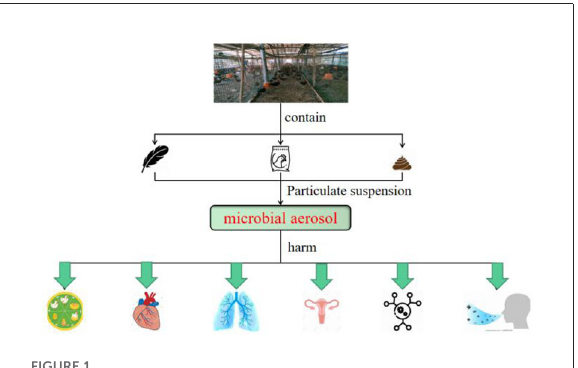
FIGURE1 Hazards of microbial aerosol in animal